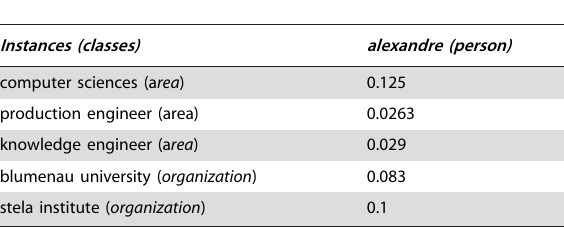
Table 1. Example of degree of correlation among the instance ‘‘alexandre’’ and other instances and respective